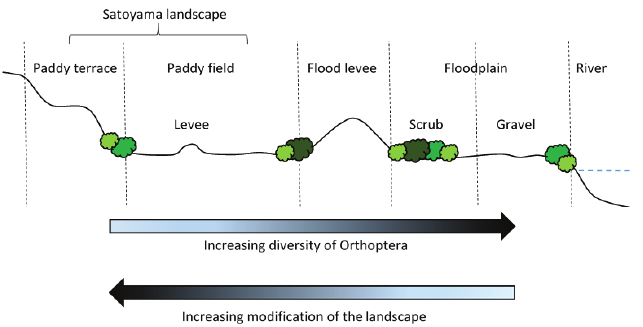
Fig. 7. Cross section of a floodplain ecosystem in relation to di- versity of Orthoptera and anthropogenic modification of the land-